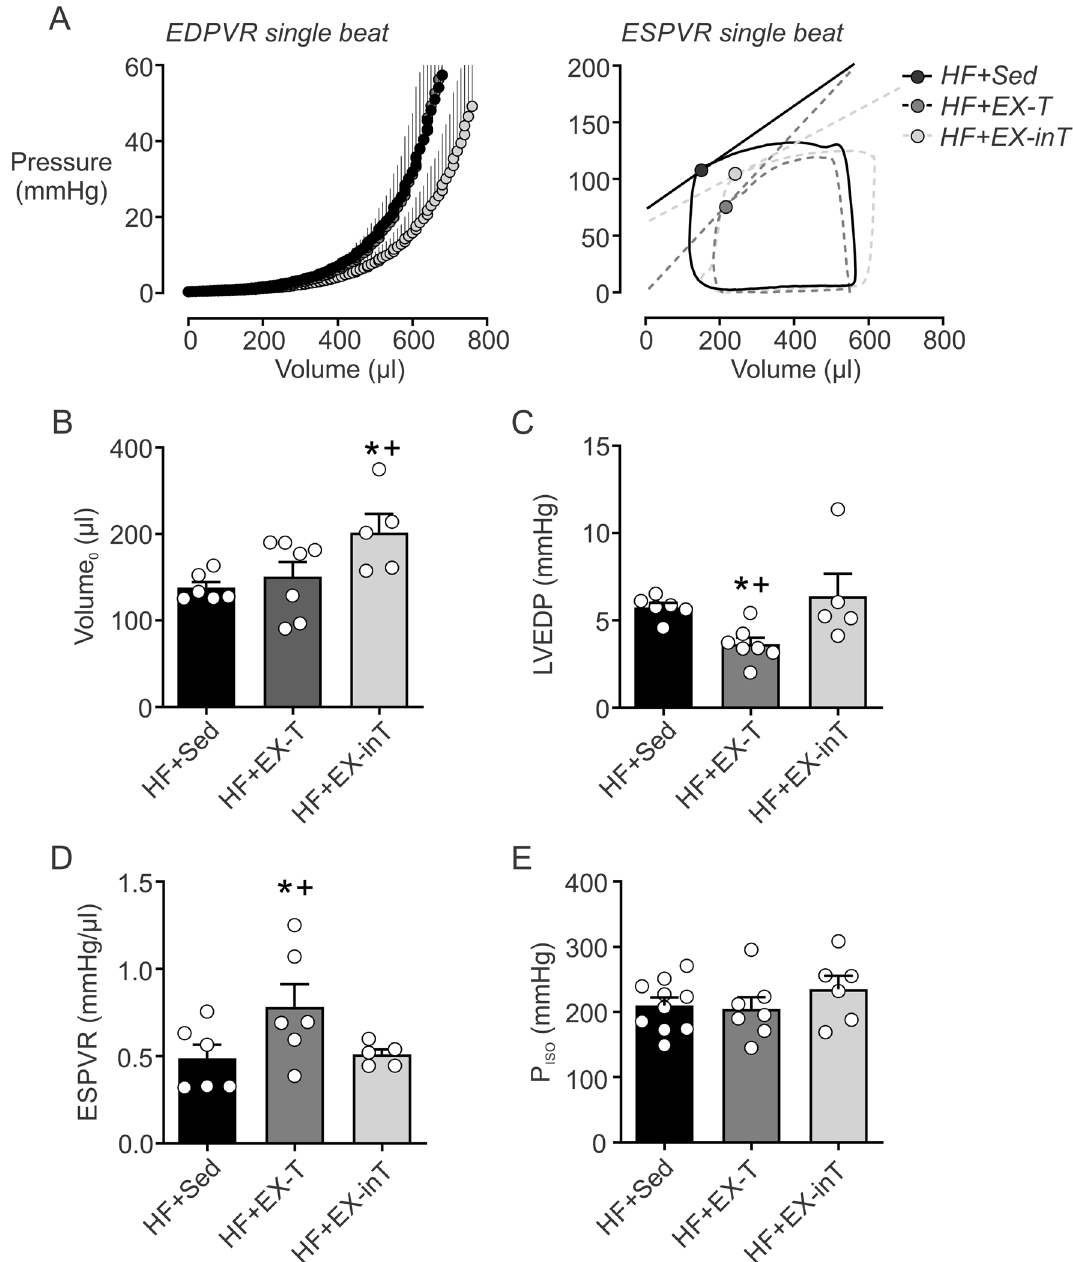
Figure 3. Diastolic function, but not systolic function is worse in heart failure rats with exercise training intolerance (HF + EX-inT). ( A ) (Left) end-diastolic pressure–volume relationship (EDPVR) by single beat analysis and (right) end-systolic pressure–volume relationship (ESPVR) by single beat analysis. ( B ) Summary of the effects of EX on the volume at pressure 0 (EDPVR single beat). Note that HF + EX-inT rats showed a significant increase of volume at pressure 0. ( C ) Summary of the effects of EX on LVEDP. Note that HF + EX-T improves diastolic function. ( D ) Summary of the effects of EX on ESPVR. Importantly, HF + EX-T rats displayed a significant improvement of systolic function. (E) isovolumetric pressure (P ISO ) was not different between all groups. *p < 0.05 vs. HF + Sed; + p < 0.05 vs. HF + EX-T condition. HF + Sed, n = 6; HF + EX-T, n = 7; HF + EX-inT, n = 5